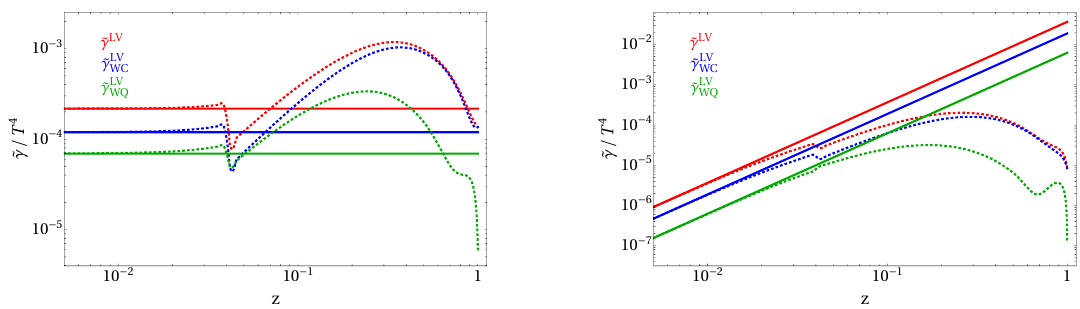
Figure 4. Temperature dependence of (cid:13) LC and (cid:13) LV (see appendix A) with stripped-o(cid:11) Yukawa couplings (denoted with tilde). We take (cid:22) 2 = 1 TeV, m N = 400 GeV and the values of the scalar 2 couplings are given in table 2. The T 4 dependence is factored out in both panels. In both panels, the dashed (solid) lines correspond to the regime where bare (thermal) mass contributes. At z (cid:25) 0 : 05 thermal corrections are as big as the bare mass, indicating a change of considered regime.